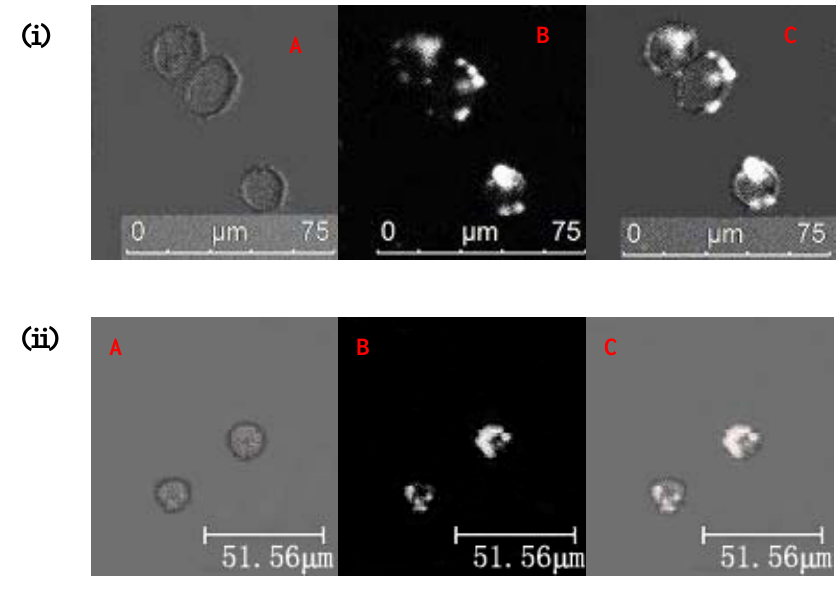
Figure 1. Fluorescent images of Tca8113 and U14 cells 2 h post labeling with QD800. Top panel: Tca8113 cells labeled with QD800; bottom panel: U14 cells labeled with